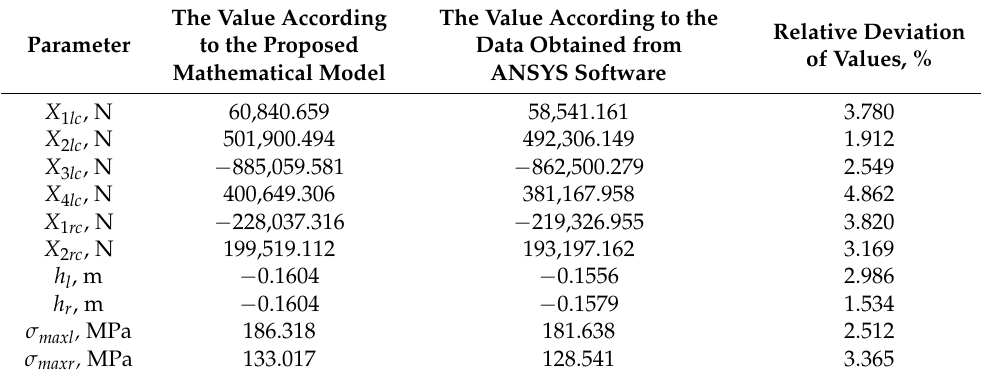
Table 5. The results of the calculation of the reaction forces arising in the hydraulic cylinders of the devices when fixing the position of the modeled pipeline, and the forces required to center its ends. The Value According to the The Value According Data Obtained from Parameter to the Proposed ANSYS Software Mathematical Model